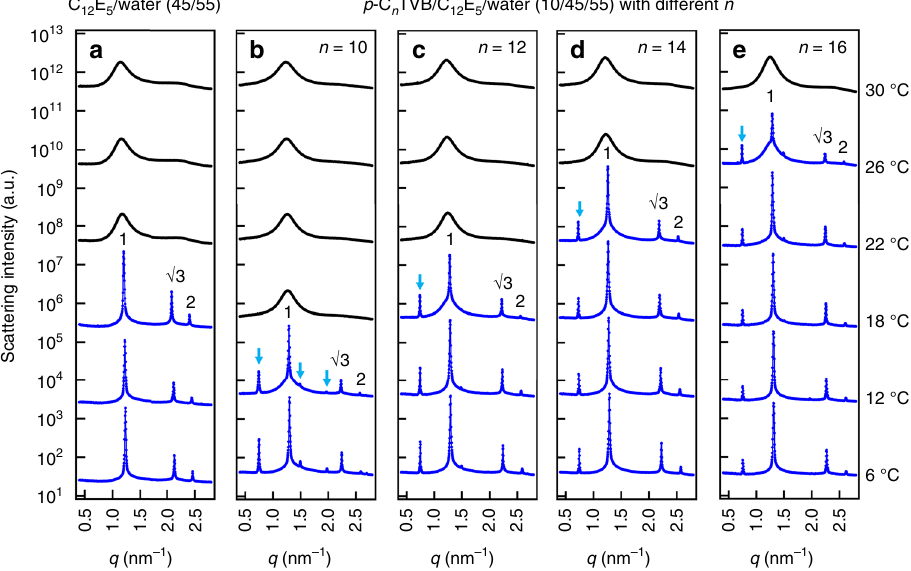
Fig. 3 Effects of diameter ratio and temperature on the binary mixtures. SAXS intensities of a C 12 E 5 /water (45/55) and b – e p -C n TVB/C 12 E 5 /water (10/45/55) for n = 10, 12, 14, and 16 at different temperatures. All measurements were performed upon cooling down from 30 to 6 °C. Scattering intensities are shifted vertically for visual